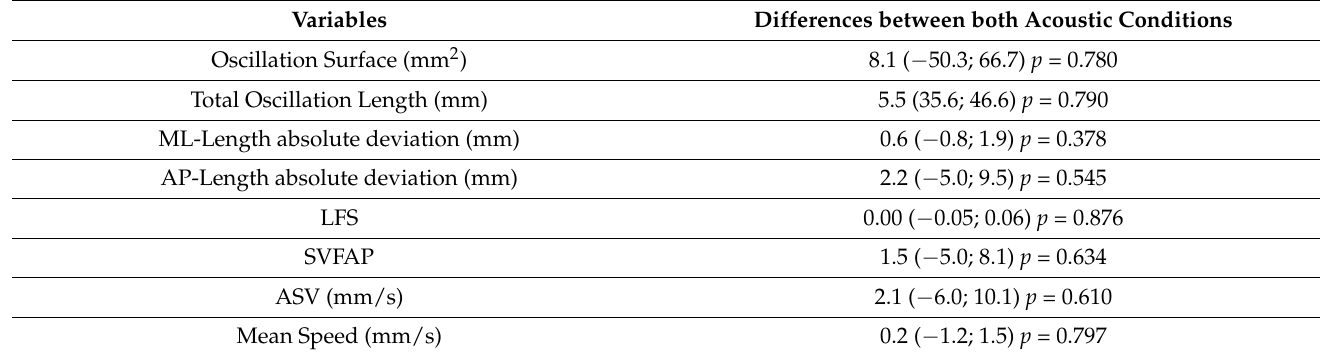
Table 4. Static posturography score differences between acoustic conditions.